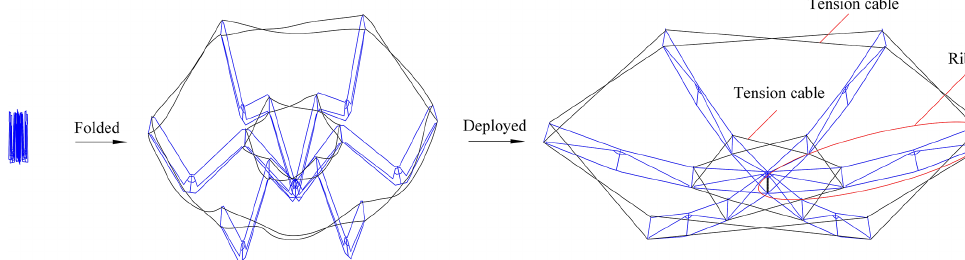
Figure 3. Configuration scheme of a hexagonal prism module.